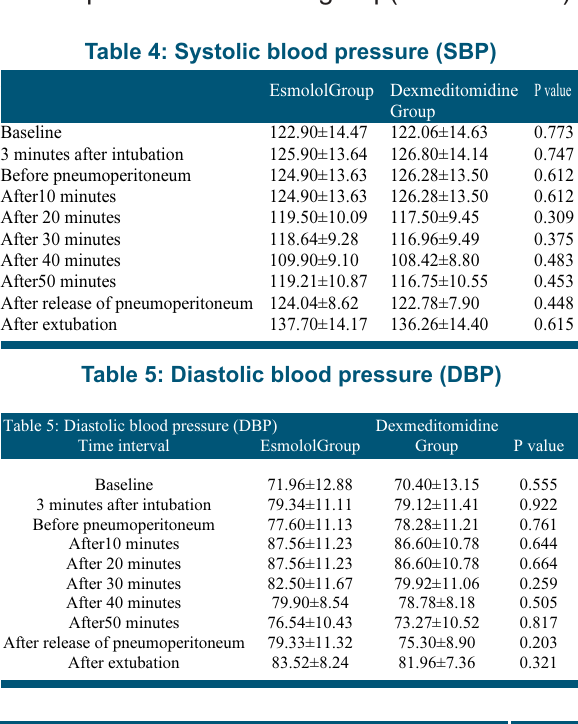
Table 1: Demographic data of the patient